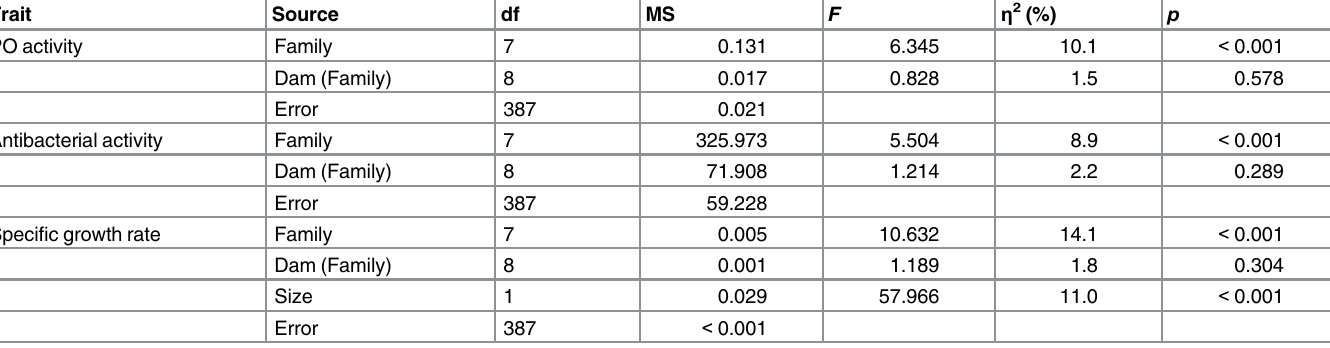
Table 1. AN(C)OVAs for PO activity and antibacterial activity of snail hemolymph, as well as for specific growth rate of snails during the last five weeks of the study.